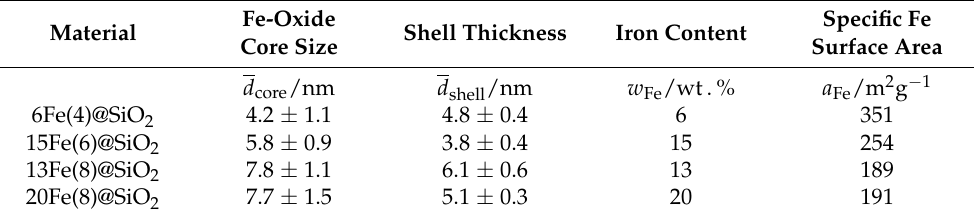
Table 3. Average core size d core of as-made Fe@SiO 2 core-shell particles and the respective SiO 2 shell thickness d shell measured from TEM micrographs: iron w Fe content and specific surface area a Fe calculated from measured values via Equations (2) and